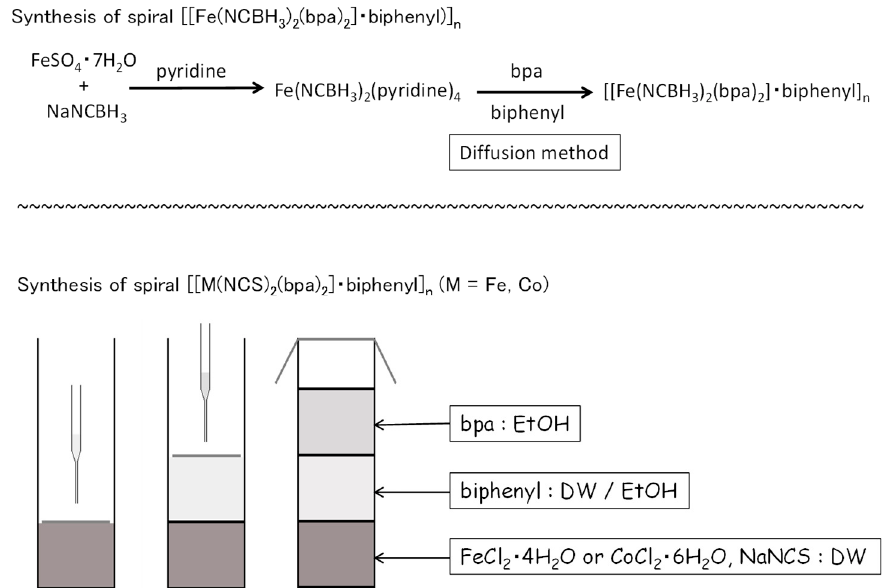
Table 2. Crystal data of [[Fe(NCS) 2 (bpa) 2 ]·biphenyl] n .